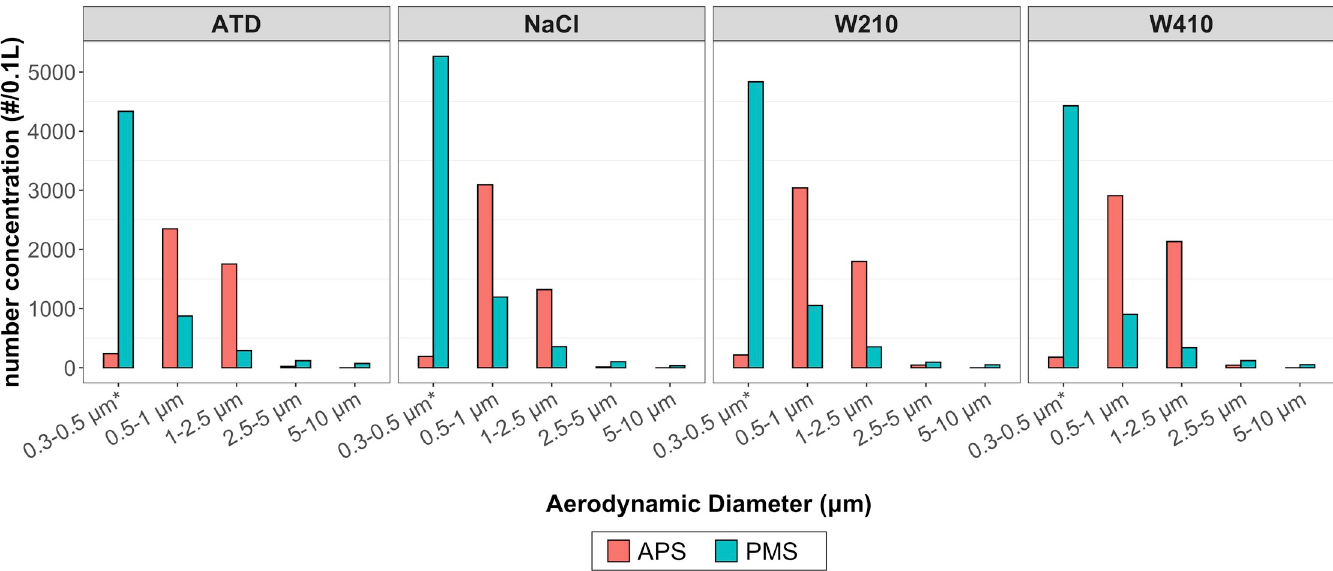
Fig 4. A comparison of the size distribution measured by the APS and PMS using OEM calibration: Data from one of the six PMS for ATD, NaCl, W210, and W410 particles taken 15 minutes after the aerosols were introduced into the chamber. The data from APS bins are aggregated to match the size bins reported by PMS. For PMS bin 0.3–0.5 μ m, APS bin < 0.523 μ m was used for comparison.